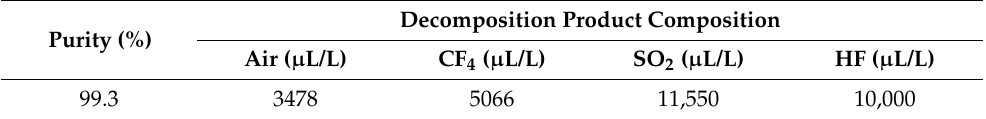
Table 4. SF 6 gas state detected in a 500 kV circuit breaker.